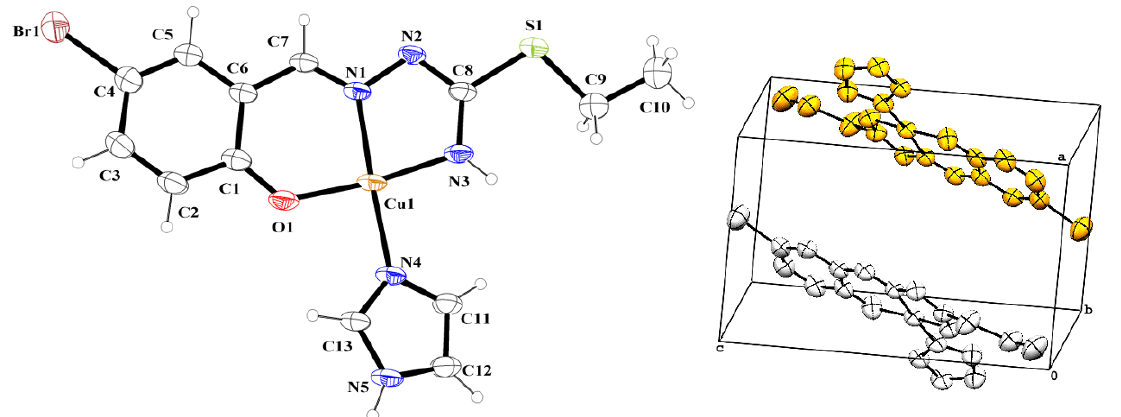
Figure 1. ORTEP drawing of the molecular structure and unit cell of the complex [Cu(L)Im].